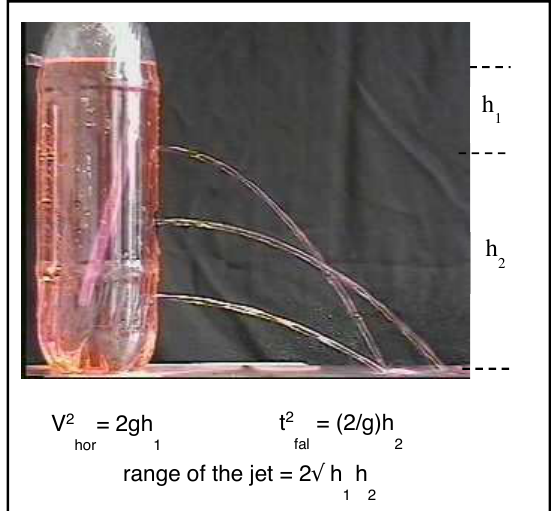
Fig. 2 . Pierced bottle: the greatest range is for the middle hole.